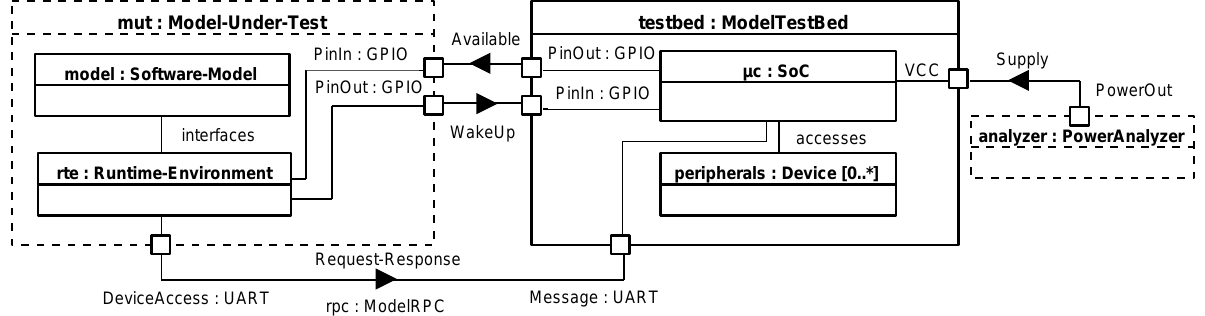
Figure 15. The ModelTestBed allows direct access to the hardware of the modeled system (SysML 1.6 internal block diagram